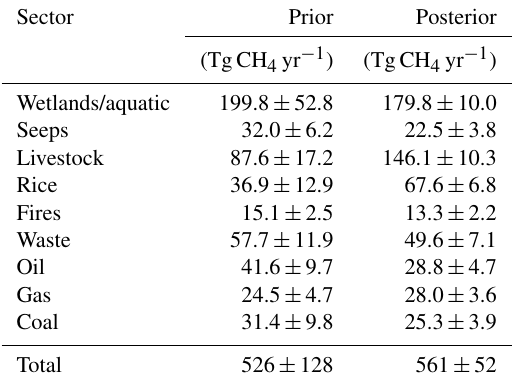
Table 1. Prior emissions and uncertainties are generated from vari- ous inventories or models (Sect. 2.3). Posterior emissions represent projection of satellite-based fluxes back to emissions while account- ing for the prior emissions distribution and covariances (Sect. 2.2). We conservatively assume uncertainties are 100% correlated, so that the total reported prior and posterior uncertainties are the sum of the individual